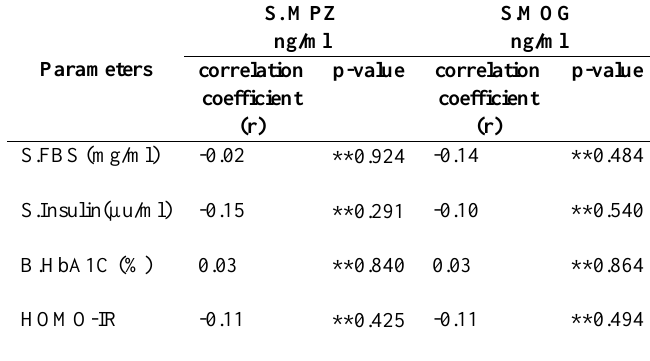
Table 4 : Correlation analysis between serum MPZ and MOG level for studied parameters in (T2DM with diabetes duration ≤ 5years) group patients